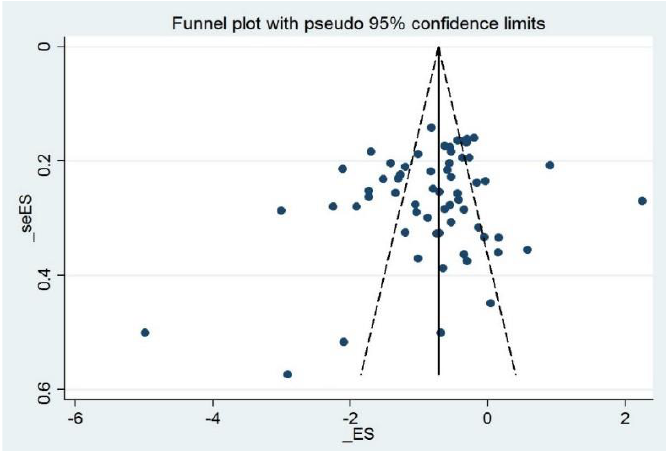
Figure 3. Funnel plot with pseudo 95% confidence limits.